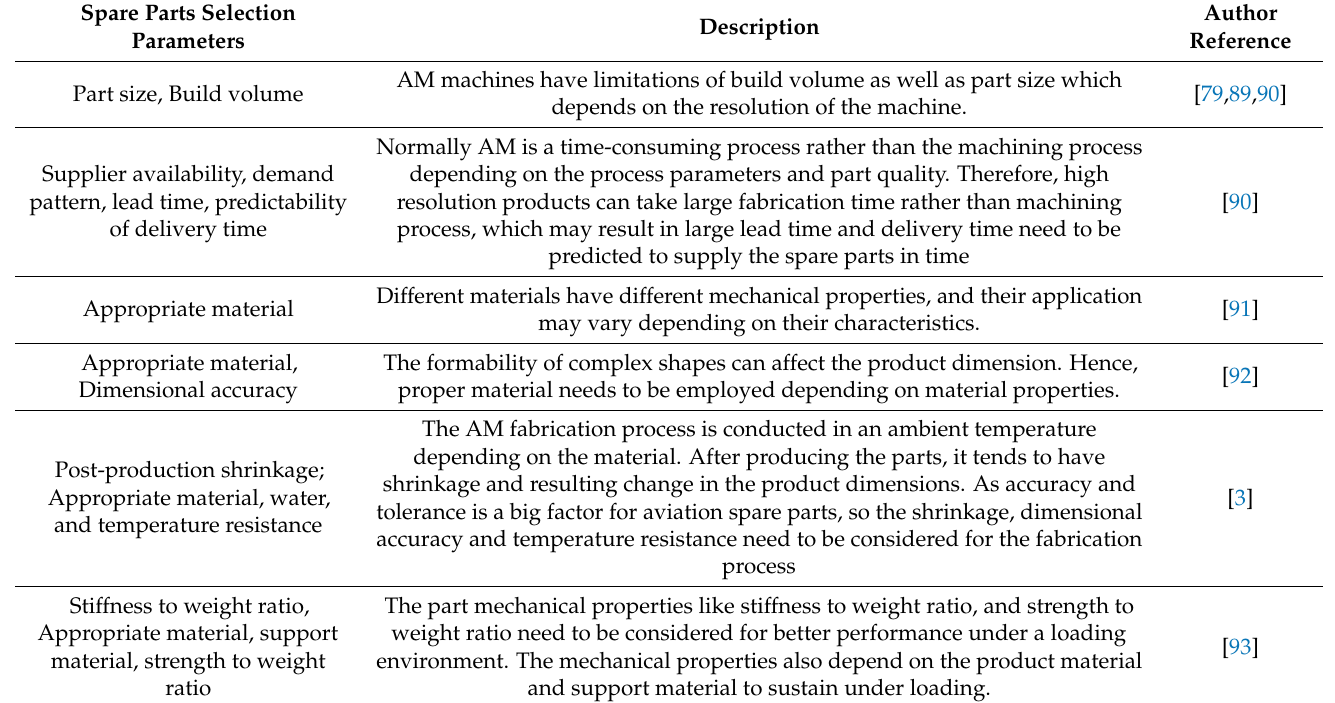
Table 6. A summary of factors for spare parts